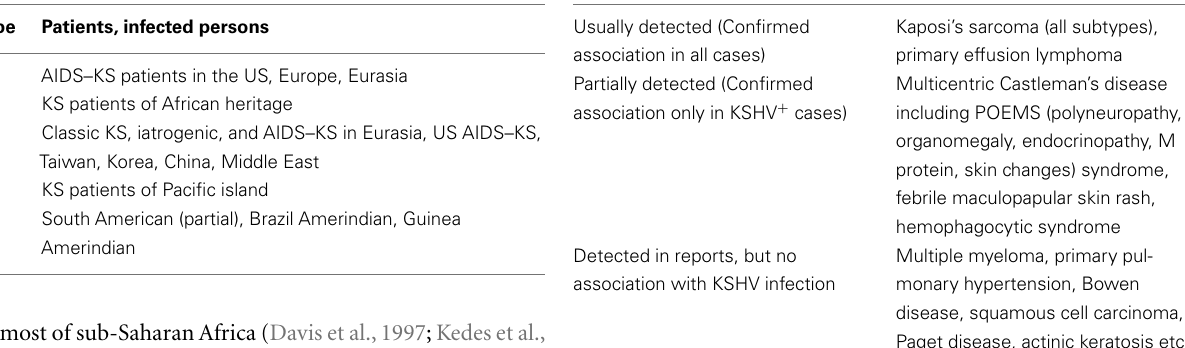
Table 2 | Kaposi’s sarcoma-associated herpesvirus genotypes. Table 3 | Kaposi’s sarcoma-associated herpesvirus and